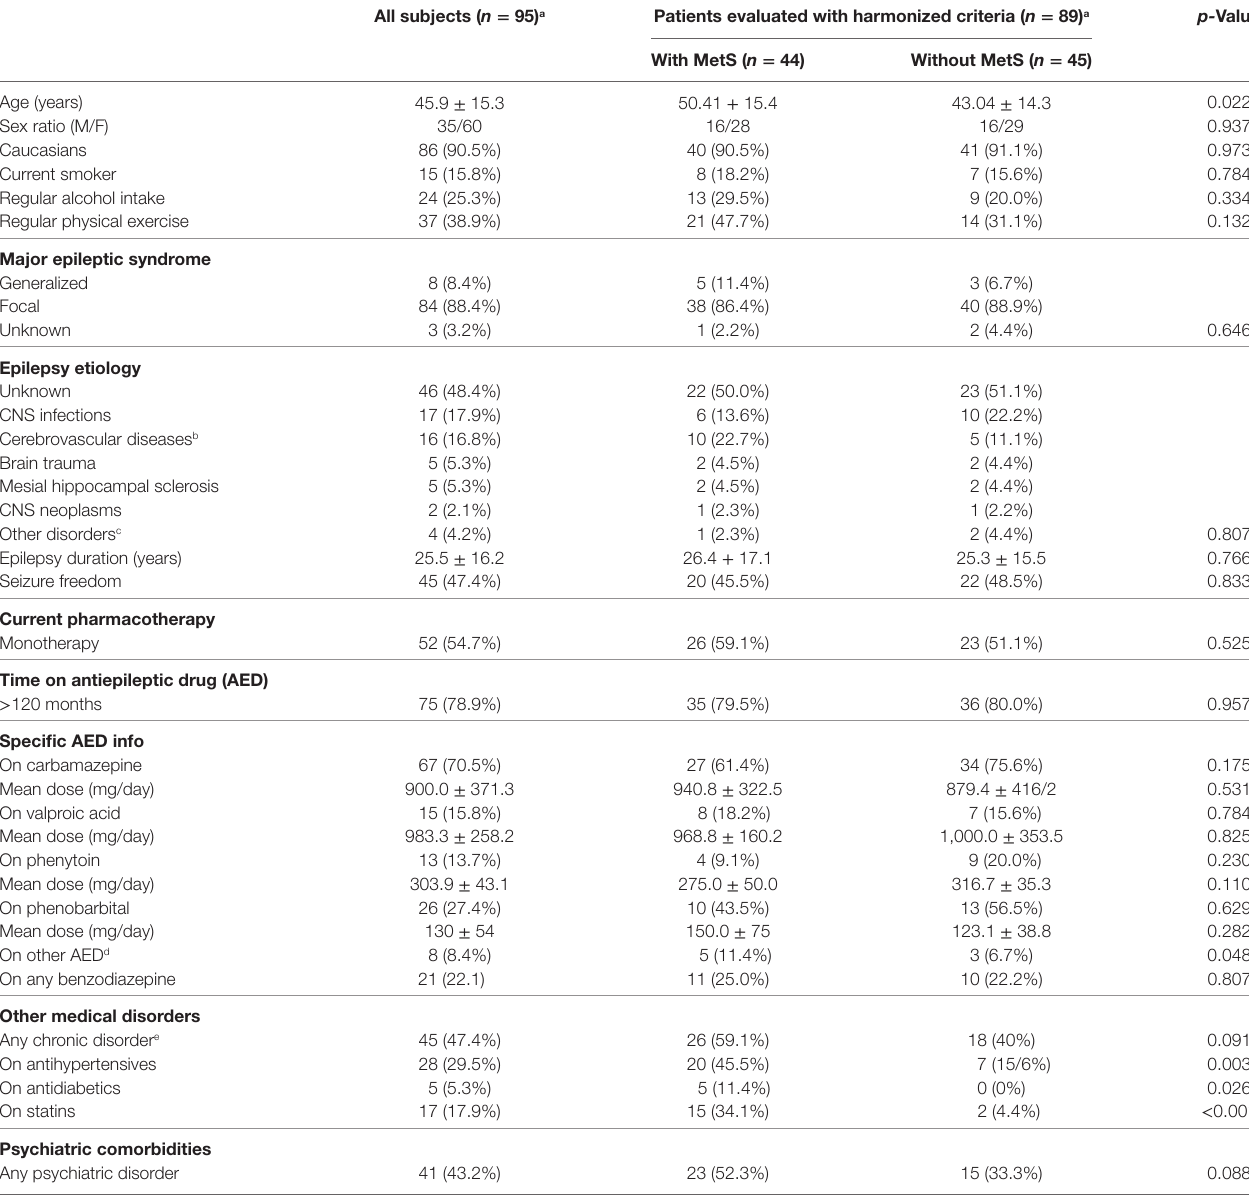
TaBle 5 | Demographic and clinical characteristics of the